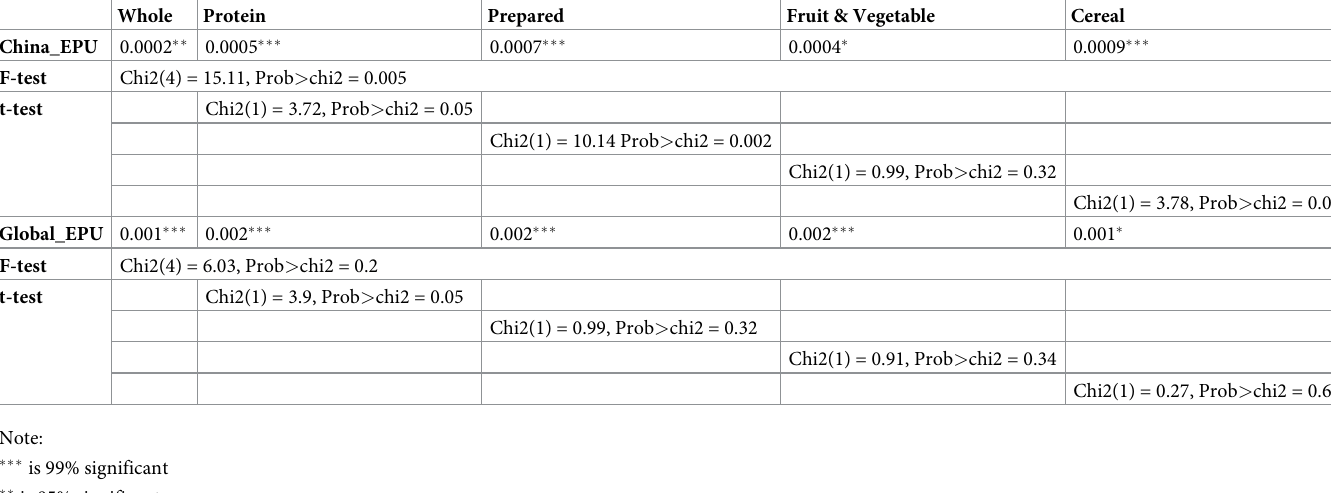
Table 6. Effects of economic policy uncertainty on different agri-food